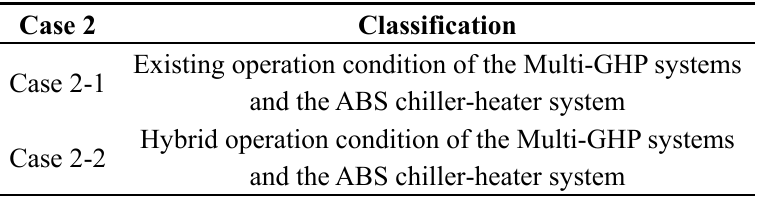
Table 7. Summary of the operation cases of a combination with the Multi-GHP systems and the ABS chiller-heater